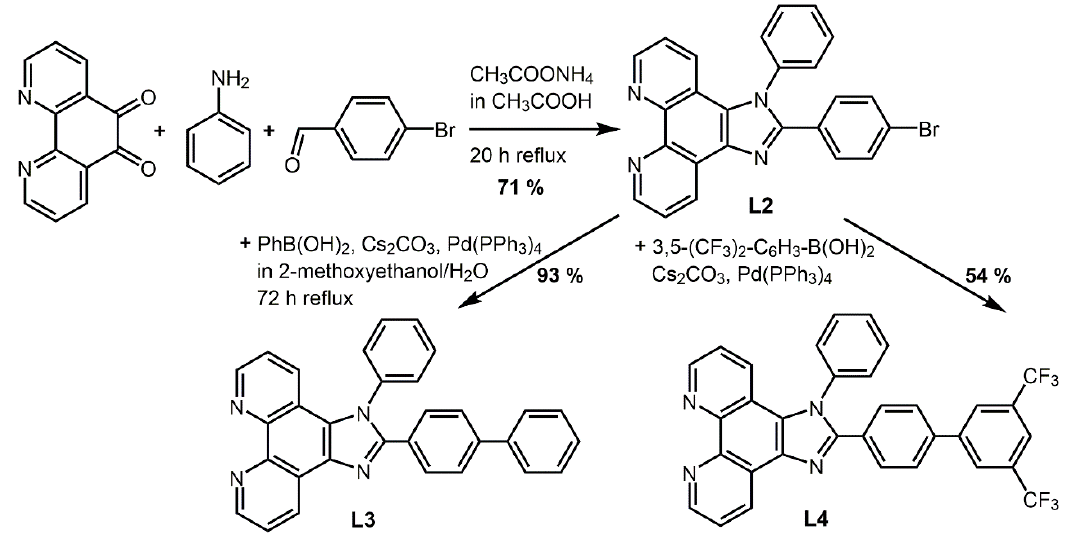
Figure 1. Synthesis details, reaction conditions, yields and labeling of the ligands L2 – L4 .